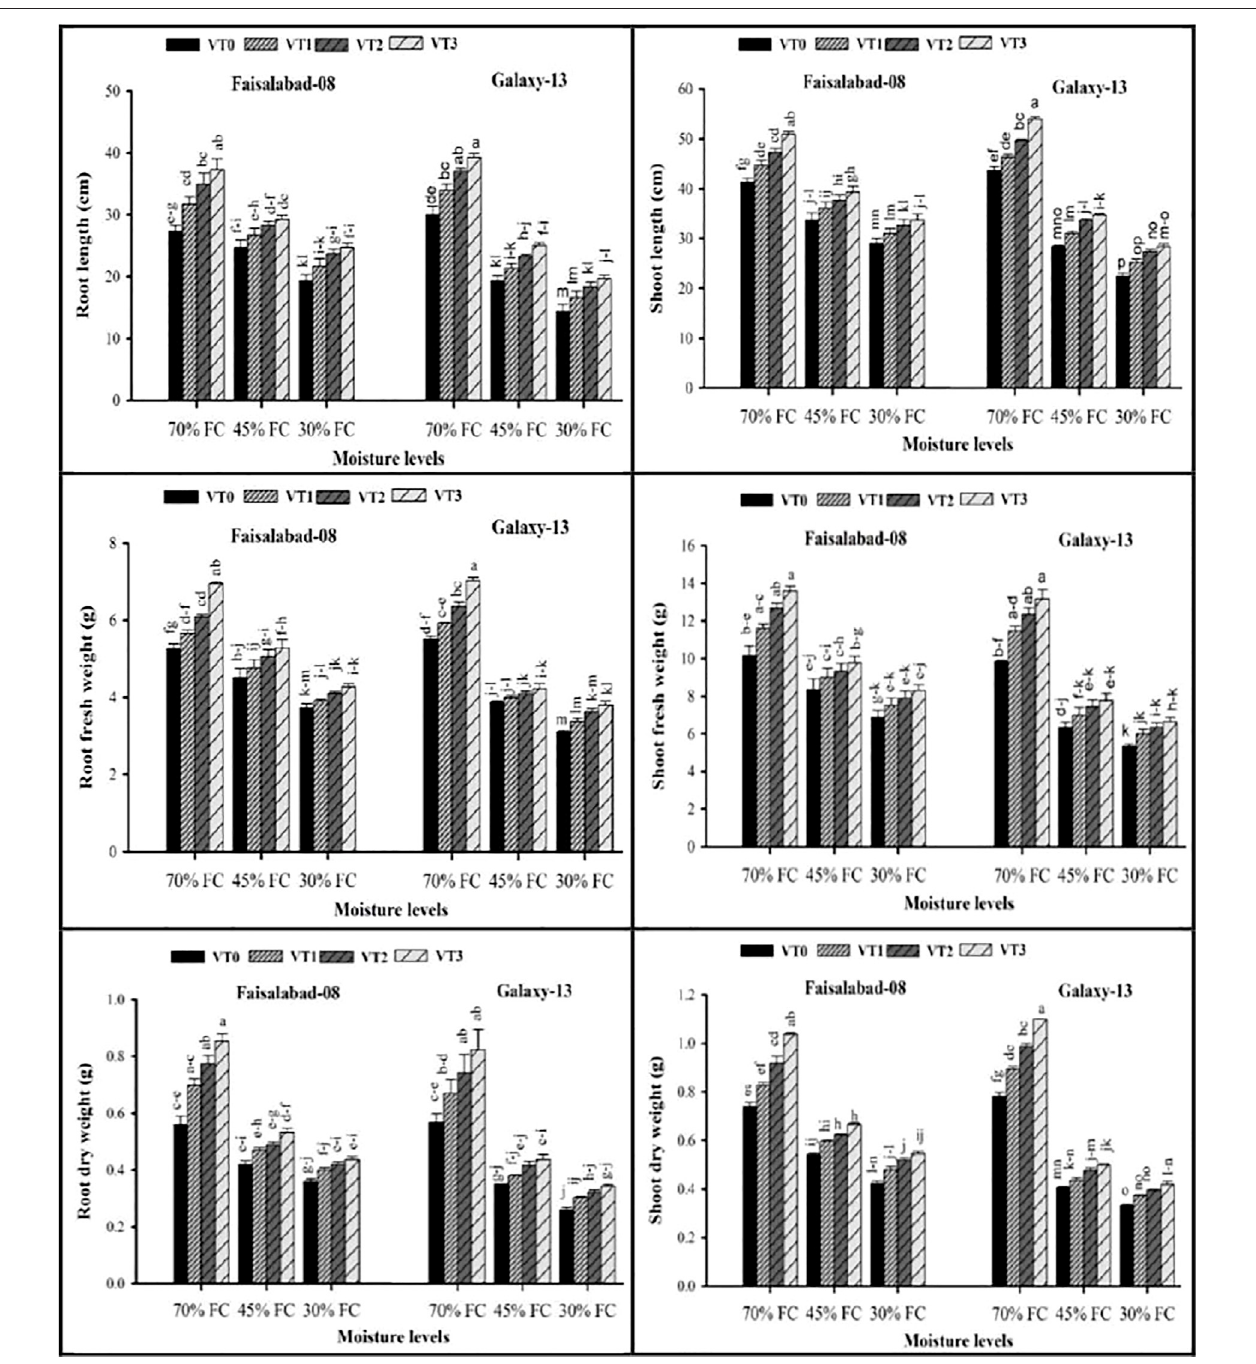
FIGURE2| Effect ofsoil-appliedwheatstrawvermicompost(VT) onrootlength,shootlength,rootfreshweight,shootfreshweight,rootdry weight,andshootdry weightoftwowheatcultivarsunderdifferentdroughtlevels[70% fi eldcapacity(FC),45%FC,and30%FC].Barswithdifferentalphabeticallettersdiffersigni fi cantlyat5% probability, according to Tukey ’ s HSD test. VT0, control; VT 1 , 4 t ha − 1 ; VT 2 , 6 t ha − 1 ; and VT 3 8 t ha − 1 .